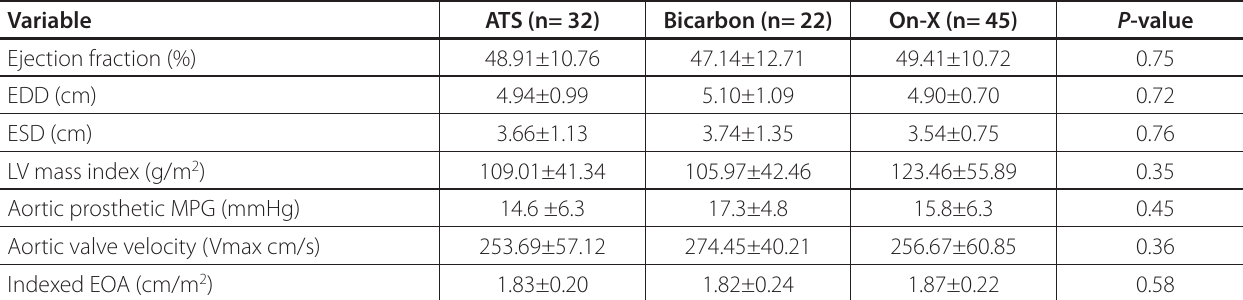
Table 3 . Postoperative echocardiographic